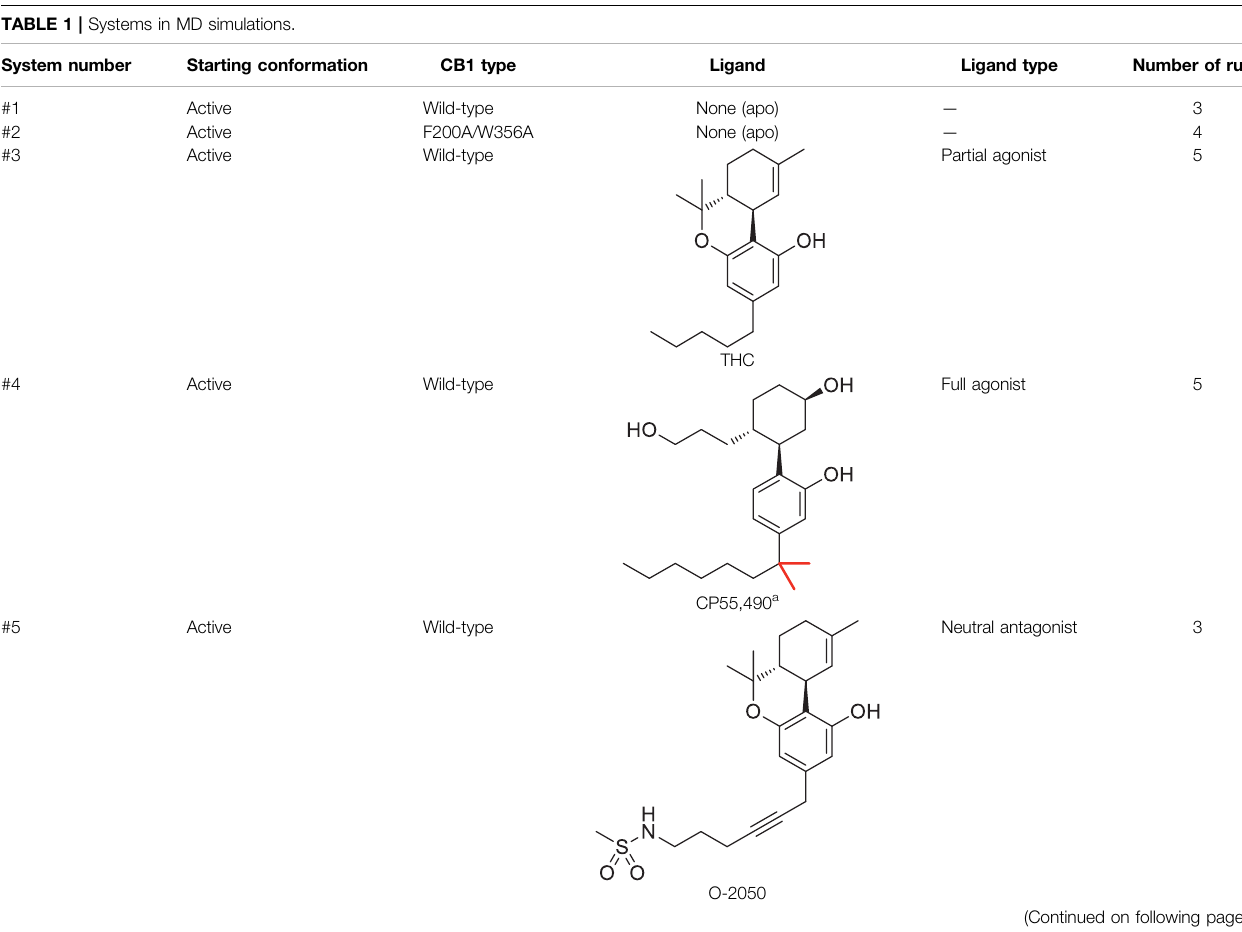
TABLE 1 | Systems in MD